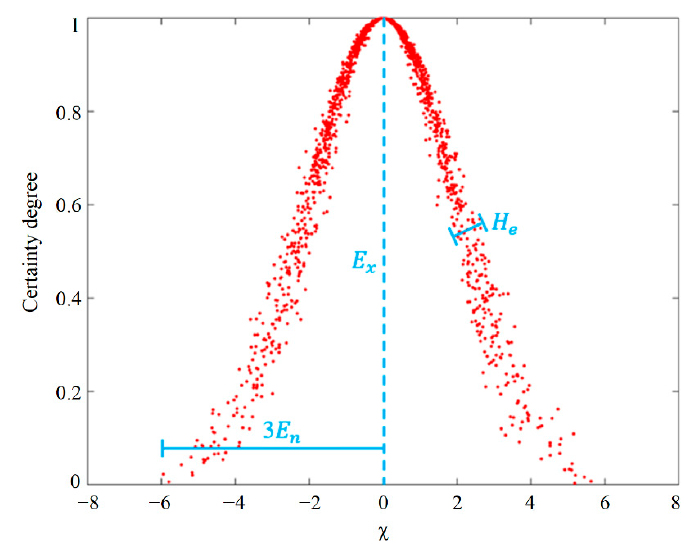
Figure 5. A normal cloud model with parameters E x = 0, E n = 2, and H e = 0.2.